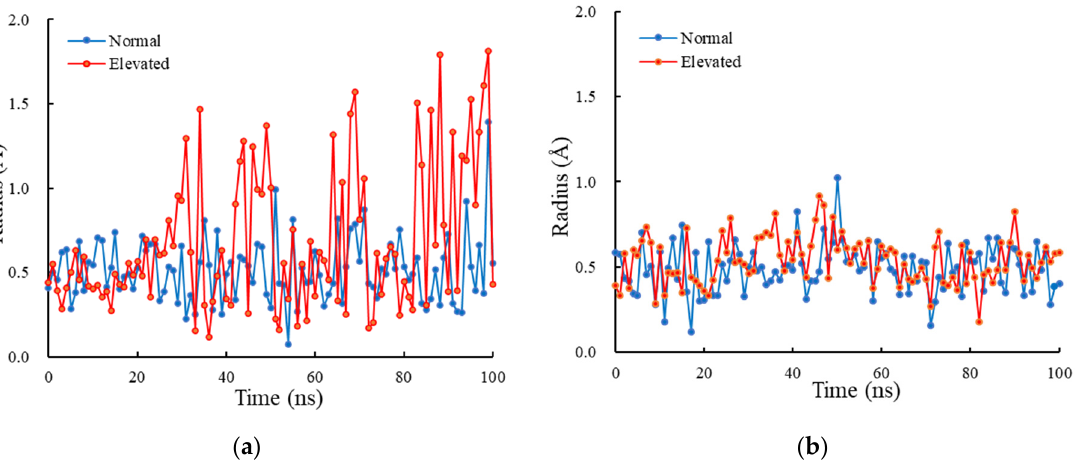
Figure 6. The lower-gate radius at normal and elevated hydrostatic pressure. ( a ) TRPV1-only model and ( b ) TRPV1 membrane-embedded model. and ( b ) TRPV1 membrane-embedded